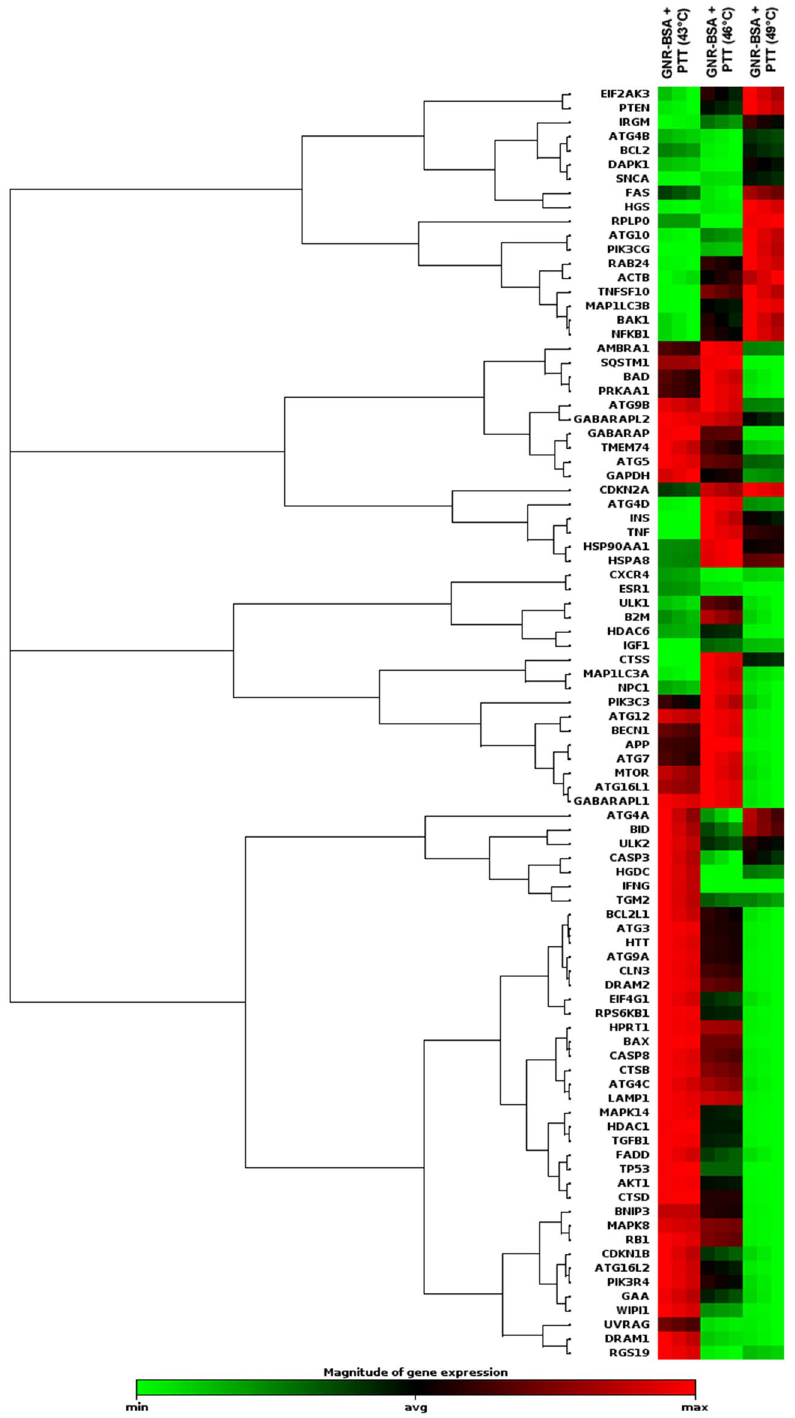
Figure 4. Clustergram illustration of PCR array for autophagy signaling. Over 80 genes were monitored in CSCs after 8-min exposure to 43, 46, and 49